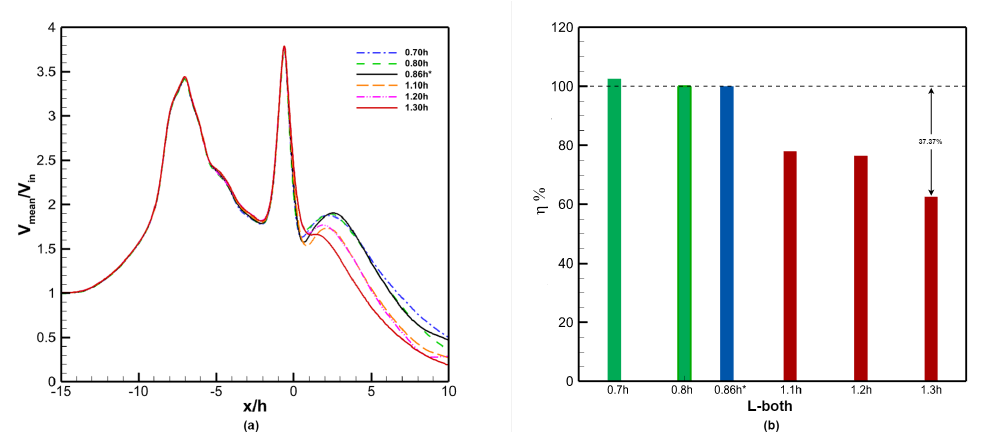
Figure 13. ( a ) Mean velocity along the centerline normalized by the inlet velocity, V in , Baseline ; ( b ) velocity ratio, η , at point x/h = 5 for the L-both